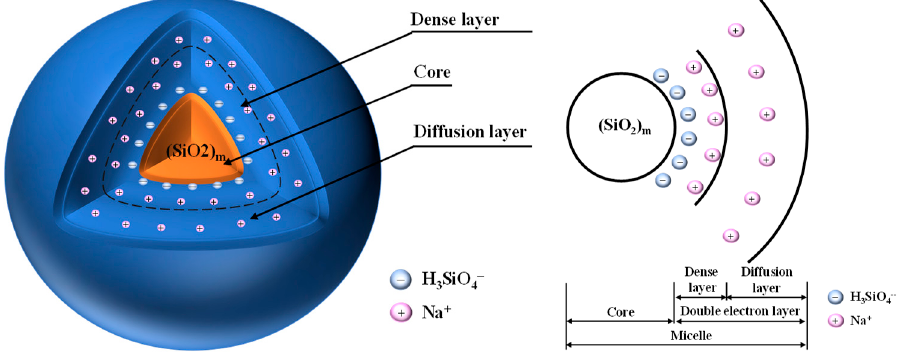
Figure 7. The bilayer structure of the waterglass particle.